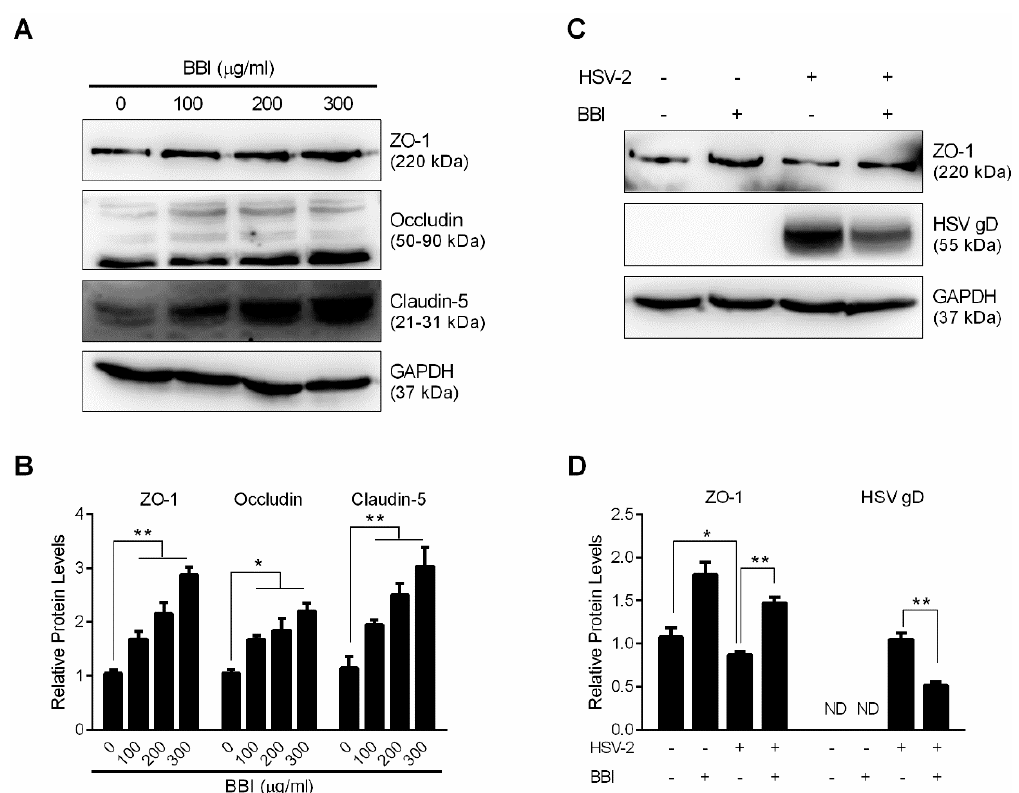
Figure 7. Effect of BBI on HSV-2-induced tight junction protein downregulation. ( A ) End1/E6E7 cells were treated with BBI at indicated concentrations for 48 h. ( C ) End1/E6E7 cells were infected with HSV-2 (MOI of 0.001) for 2 h, then cultured with or without BBI for 48 h. Proteins were collected and subjected to Western blot. Representative data from three independent experiments are shown. ( B , D ) Densitometry analysis of the blots shown in A and C was performed with ImageJ 1.44 software. Data shown were obtained as mean ± SD from three independent experiments (* p < 0.05, ** p < 0.01).